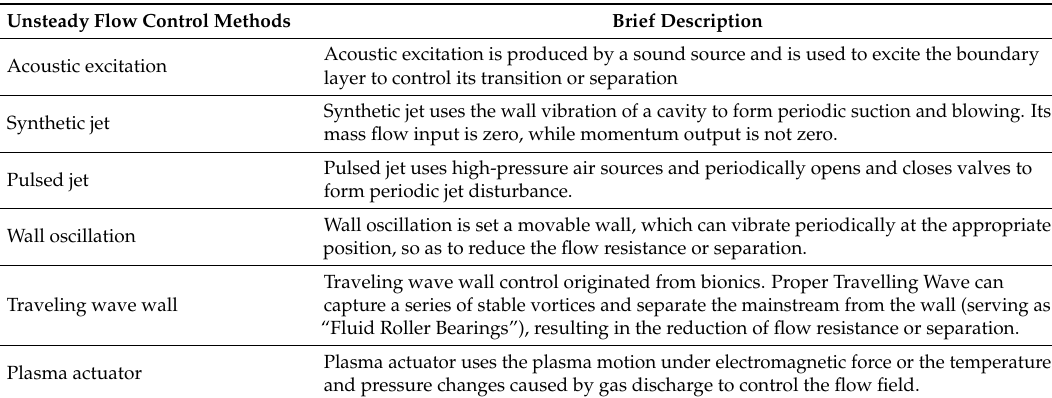
Table 1. Typical unsteady flow control